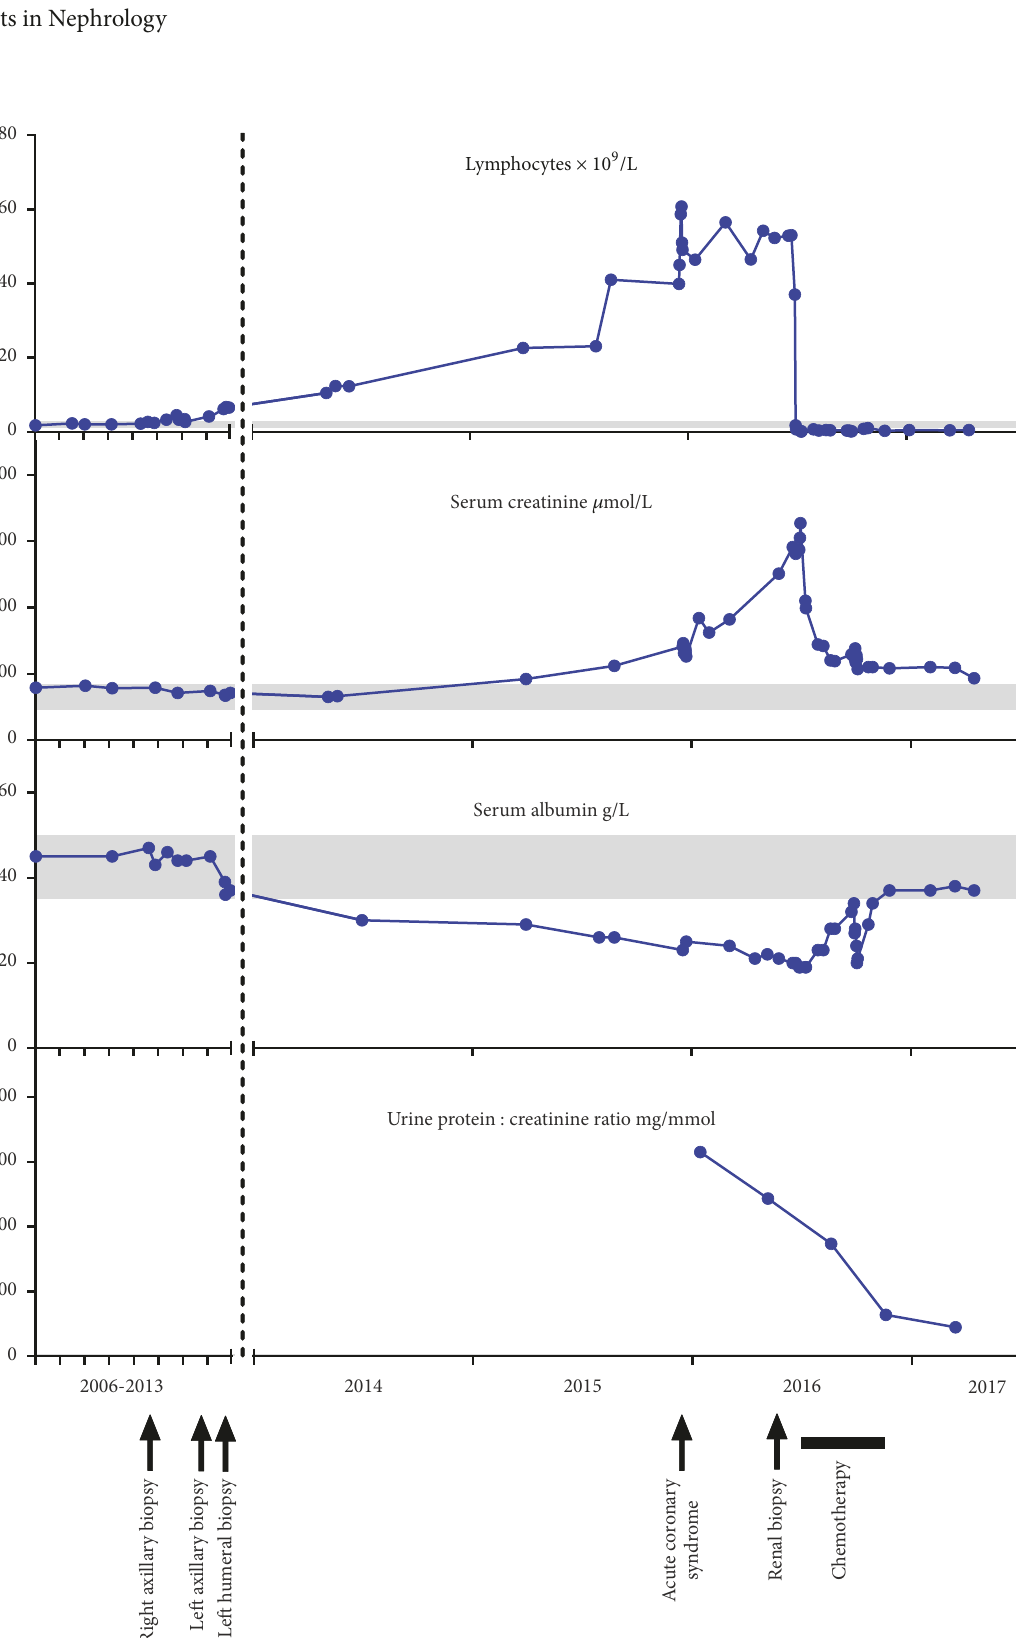
Figure 3: Patients laboratory investigations and clinical events. Shaded areas represent reference